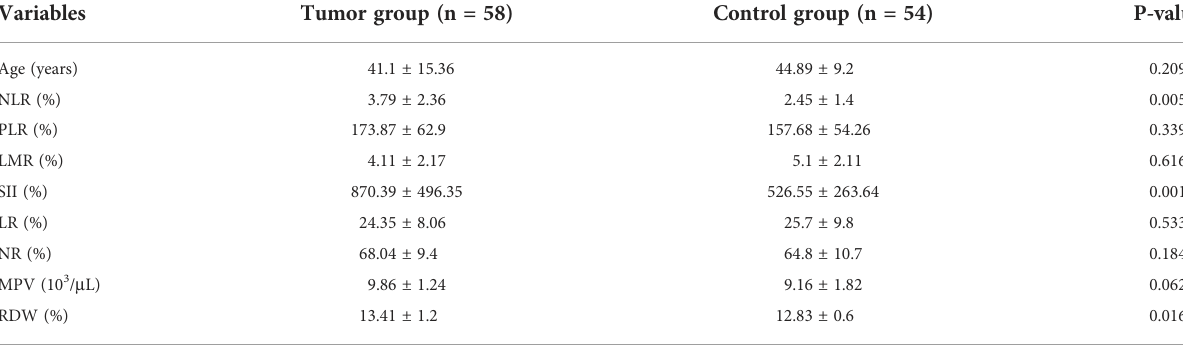
TABLE 2 Descriptive statics and comparison of CBC based parameters with respect to groups. Variables Tumor group (n = 58)